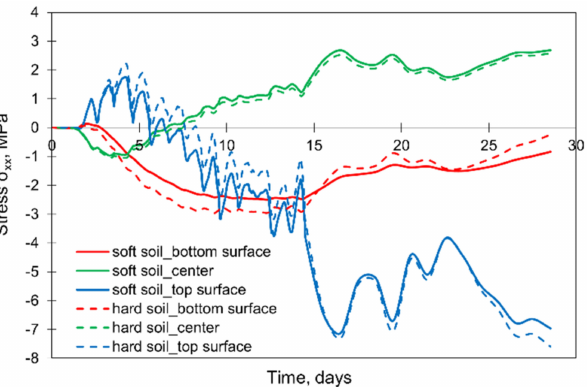
Figure 21. The effect of the soil stiffness on the development of stress σ xx